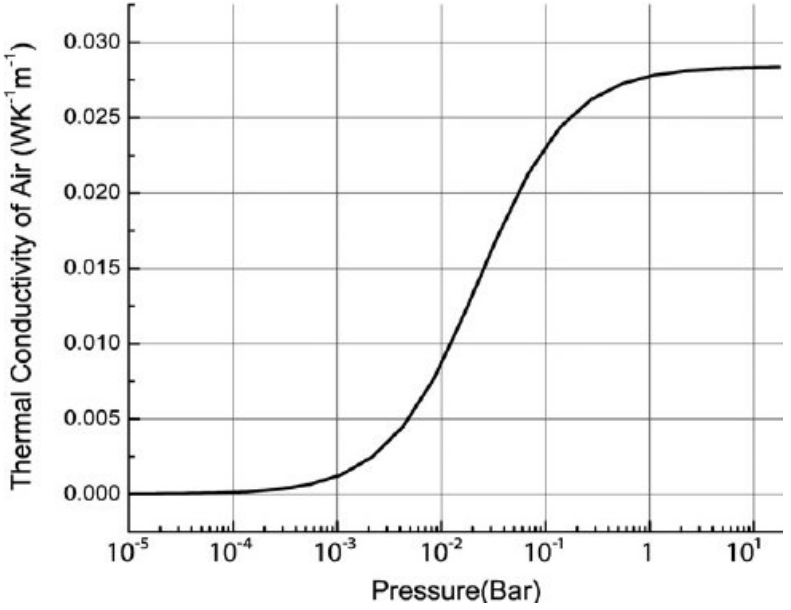
Figure 11. Thermal conductivity of air as a function of pressure. Figure from [49].